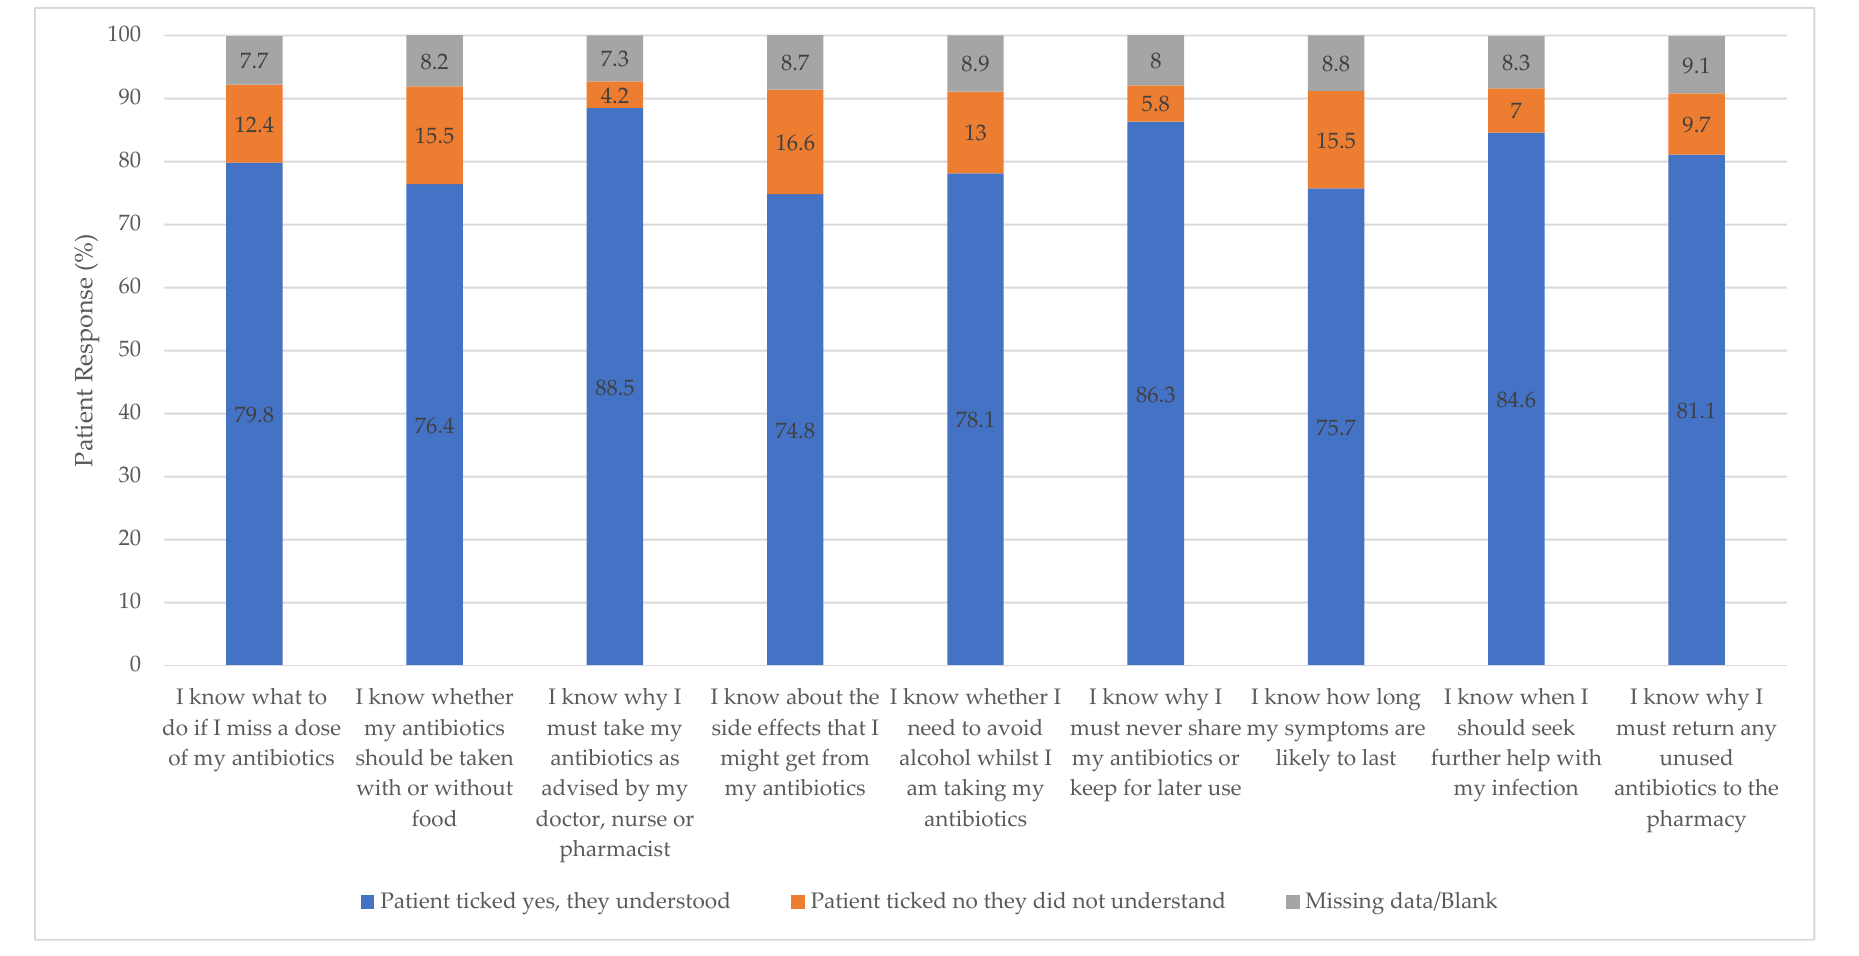
Figure 4. Patient self-reported knowledge of specific information relevant to infection and safe and effective antibiotic treatment.